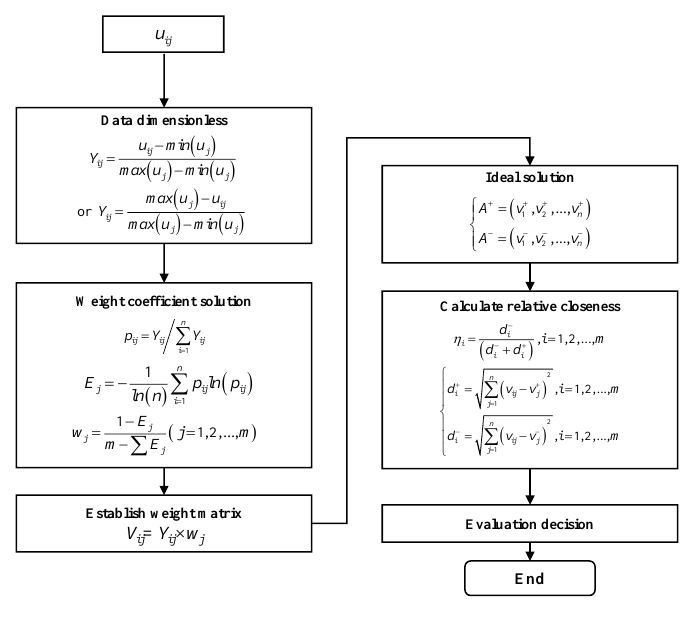
Figure 6. TOPSIS process based on entropy weight method.